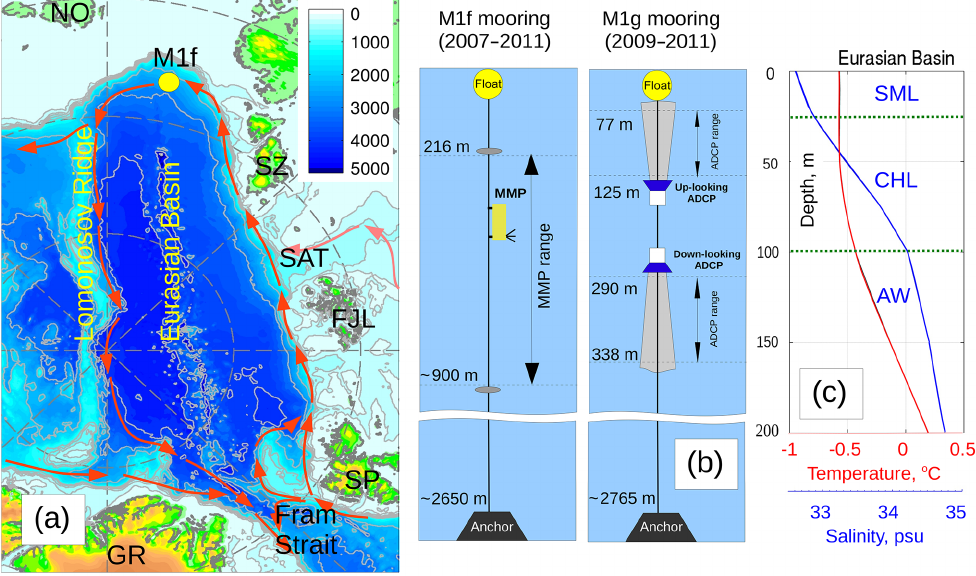
Figure 1. (a) Map showing the location of the M1f mooring (yellow circle) over the continental slope of the Laptev Sea in the Eurasian Basin of the Arctic Ocean in 2007–2011. The position of the M1g mooring is not distinguishable from M1f at these scales. Greenland (GR), Spitsbergen (SP), Franz Josef Land (FJL), St. Anna Trough (SAT), Severnaya Zemlya (SZ), and Novosibirskiye Islands (NO) are indicated. Red arrows show a schematic pattern of Atlantic Water (AW) circulation in the Eurasian Basin. Bottom depth in meters is shown by color. (b) Schematics of moorings deployed at the Laptev Sea slope in 2007–2011 (M1f mooring) and in 2008–2011 (M1g mooring). (c) Mean temperature (red) and salinity (blue) profiles in the Eurasian Basin, averaged for winter months (DJF), taken from a polar hydrographic climatology dataset (Steele et al., 2001). Horizontal green lines show the limits of the surface mixed (SML), cold halocline (CHL), and AW